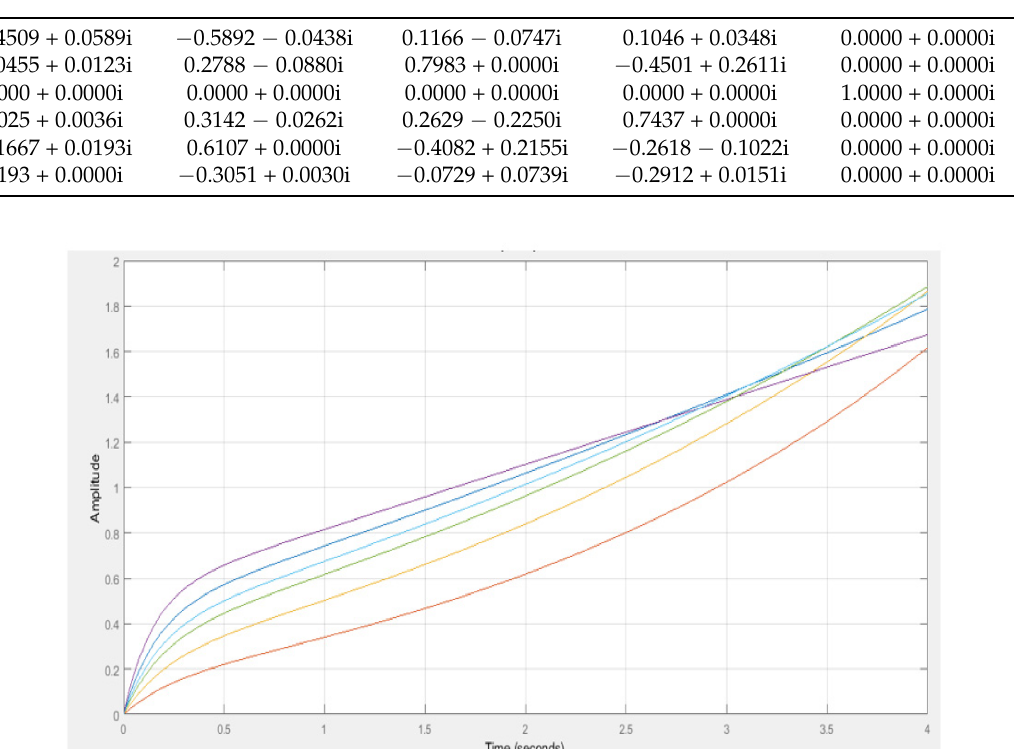
Table 7. Left eigenvector W = ˆ V new ).